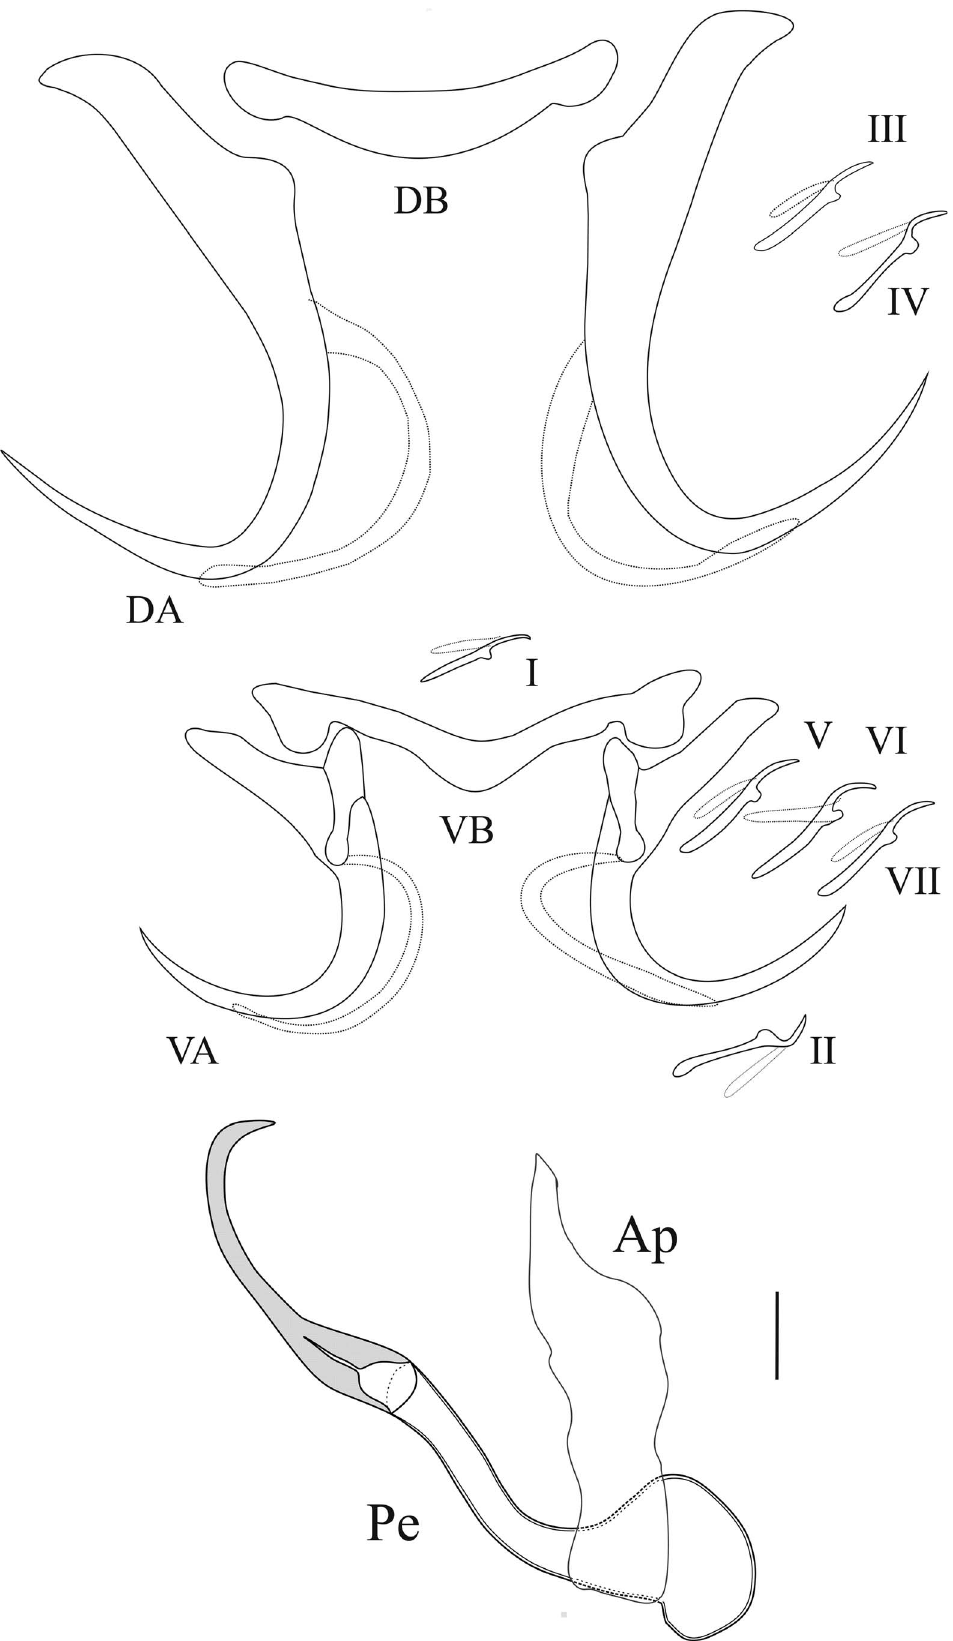
Figure 3. Hard parts of Synodontella speroadotevii n. sp. D.A: dorsal anchor; D.B: dorsal transverse bar; V.A: ventral anchor; V.B: ventral transverse bar; I – VII: marginal hooks; Ap: accessory piece; Pe: penis. Scale bar = 10 l